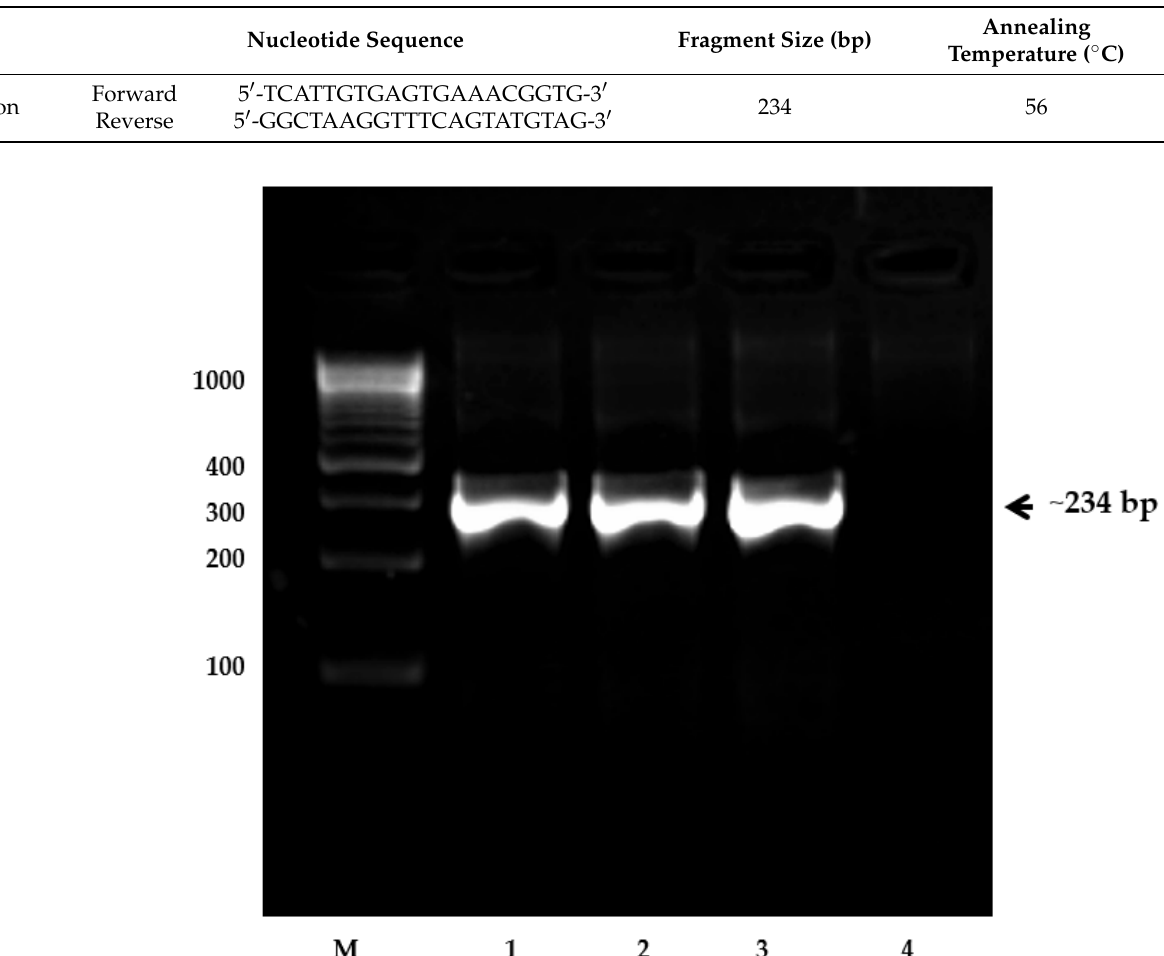
Table 1. Primers used in the confirmation of A. invadens isolate.